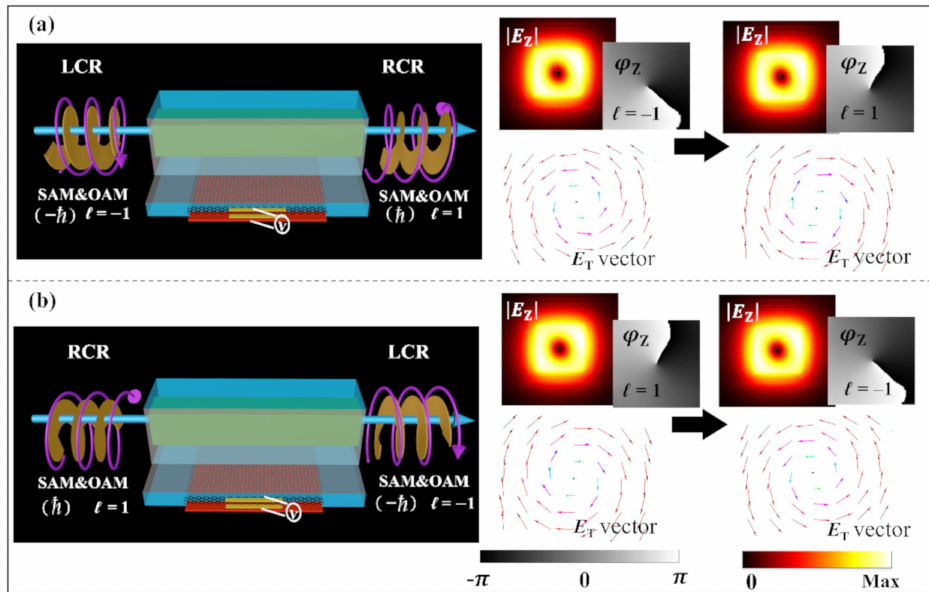
Figure 6. ( a ) Conversion of the RCP light into the LCP light. ( b ) Conversion of the LCP light into the RCP light. Simultaneous reversal of chirality and spirality (topological charge) of the waveguide modes are respectively validated by inversion of the rotating direction in the vector fields ( | E T | ) and phase distributions ( ϕ Z ), as shown in the